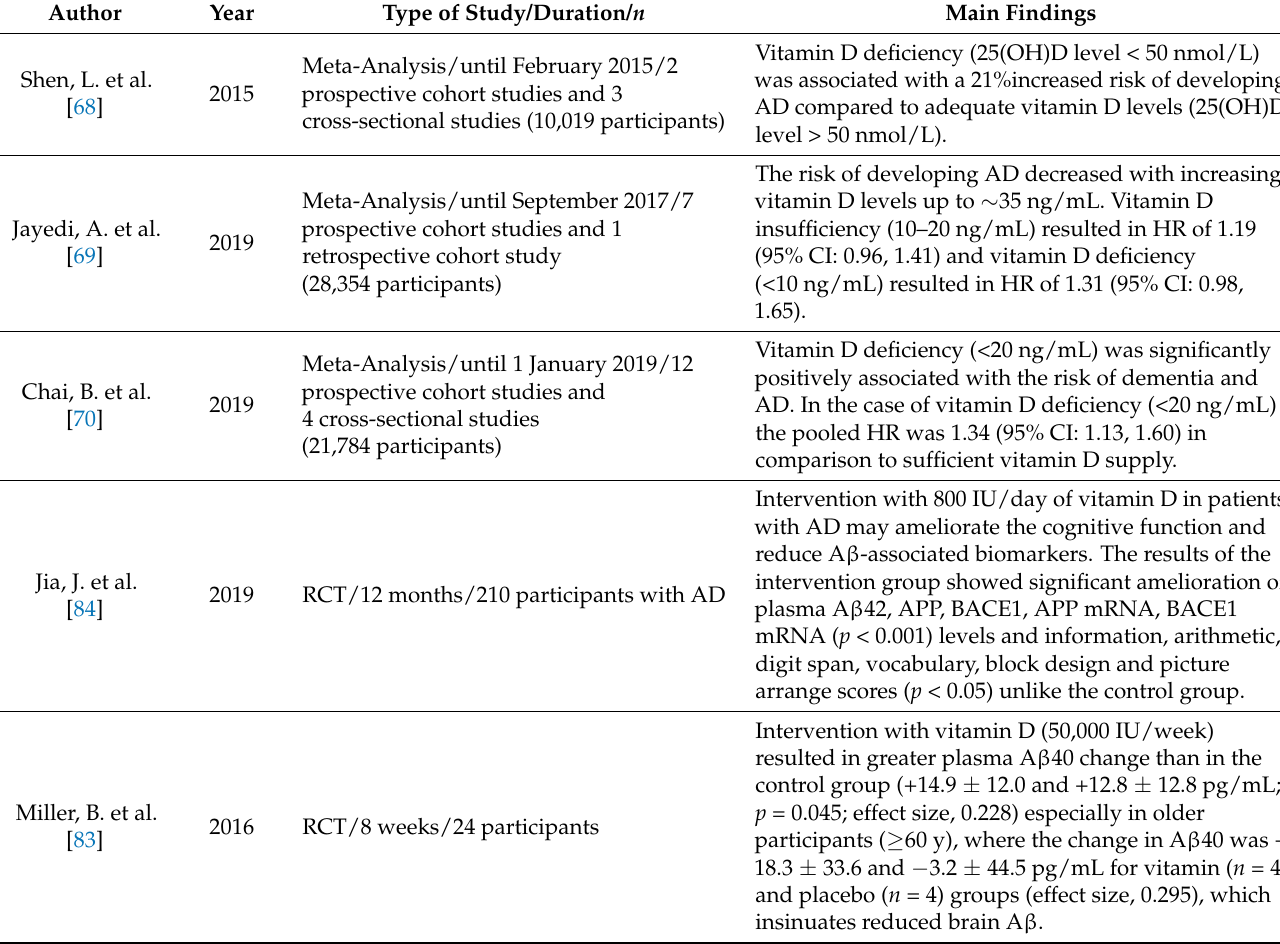
Table 3. Summary of the main results observed in cell-based studies, animal models, or clinical trials regarding vitamin D and its analogues and